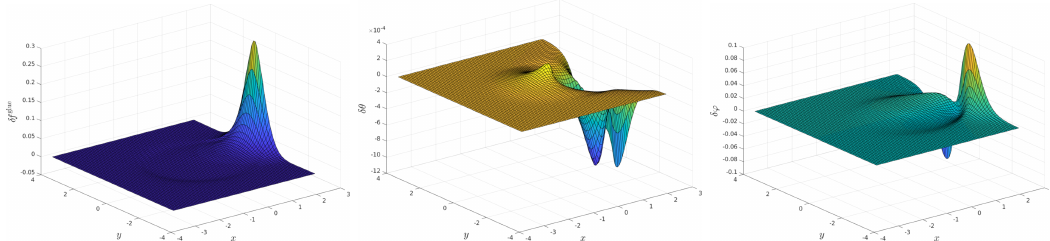
Figure 7 . Numerical solution for the fluctuation fields δf glue δθ and δϕ for the left half of a bound state of two B = 1 Skyrmions for (cid:15) = 0 . 01 and vanishing separation distance 2 a ’ 0 in the ( x, y ) - plane at z = 0